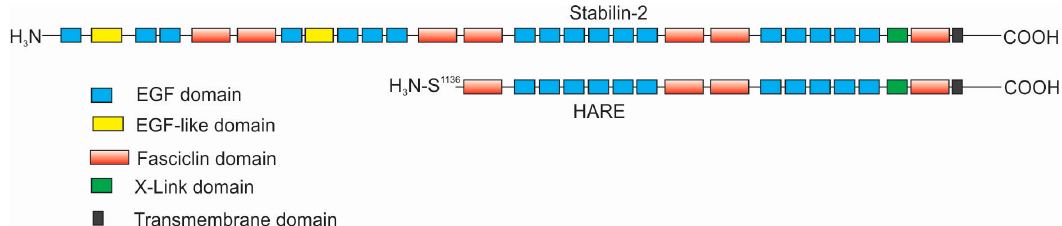
Figure 1. Domain organization of Stabilin-2 and the shorter isoform, hyaluronic acid receptor for endocytosis (HARE).